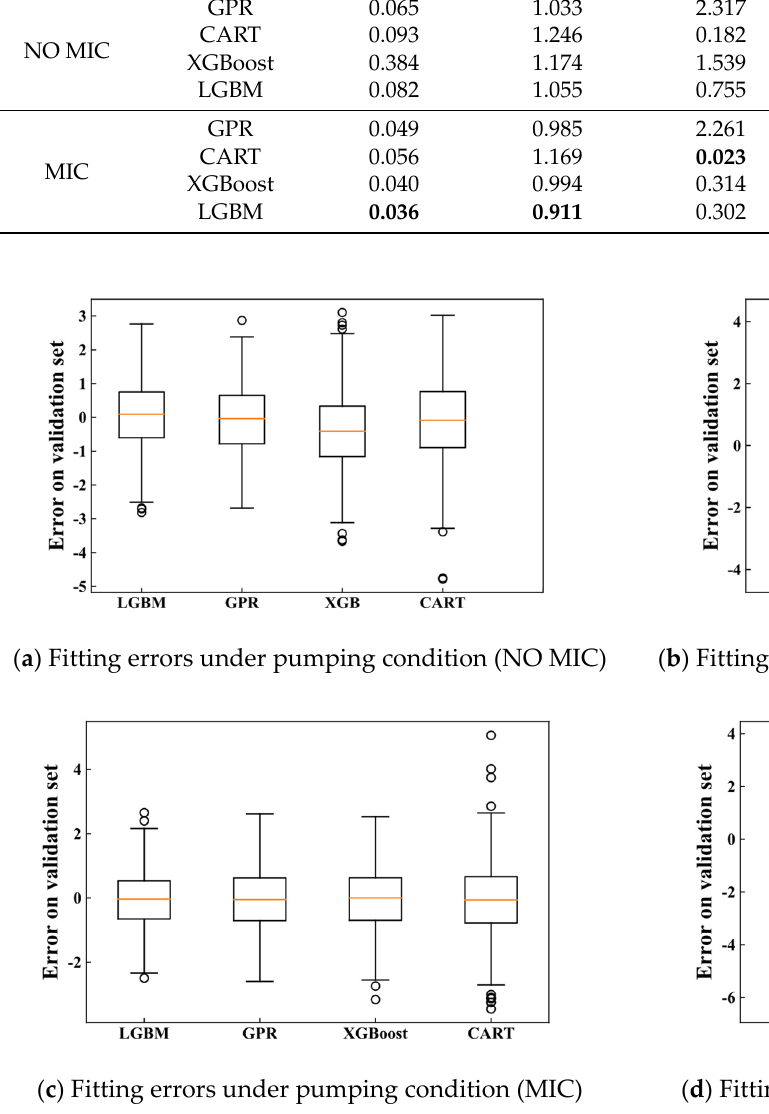
Figure 9. The box plots of fitting errors on the testing set.